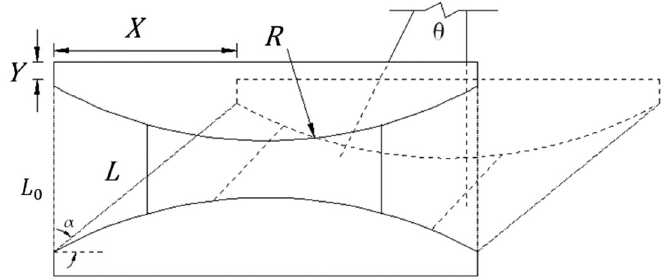
Figure 4. Stress analysis diagram of negative stiffness bearing under earthquake action.